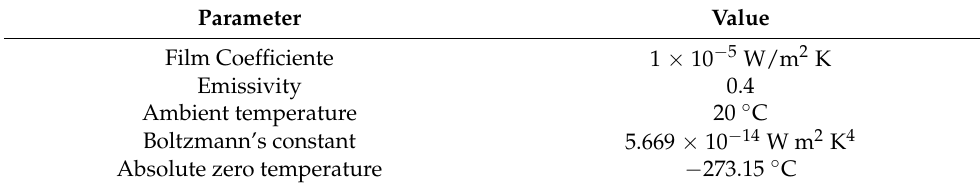
Table 7. The convection and radiation heat transfer